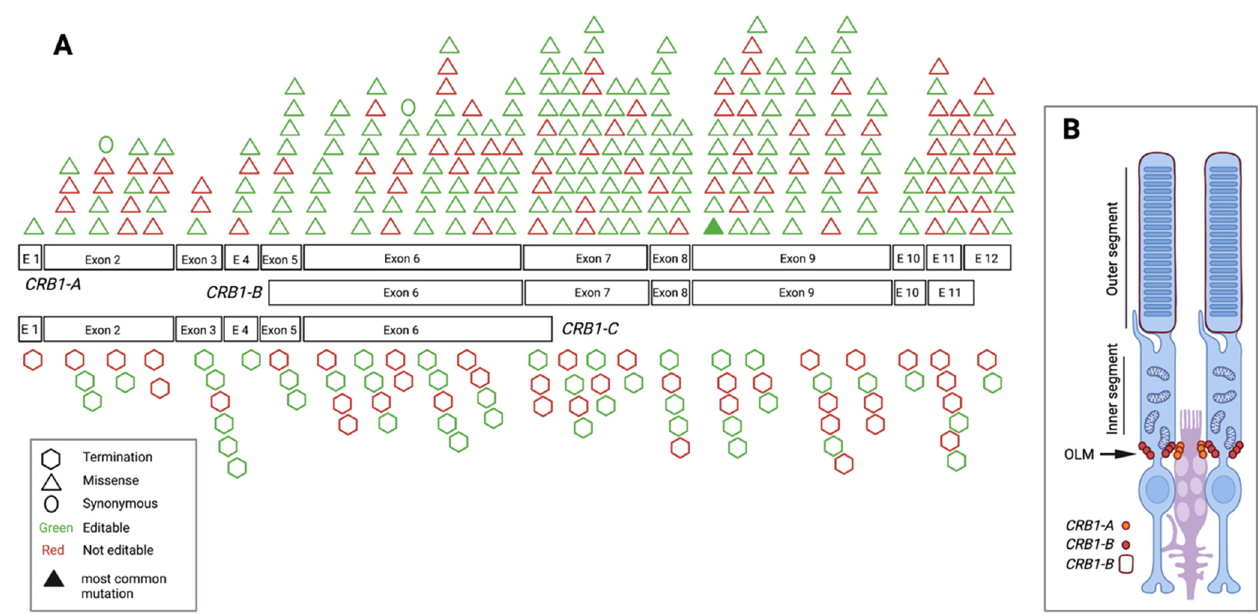
Figure 1. Schematic drawing of pathogenic, exonic single nucleotide variants (SNVs) along the CRB1 isoforms. ( A ) CRB1 has three retinal isoforms, from which CRB1-B is the most highly expressed overall. The most commonly reported pathogenic/likely pathogenic/conflicting pathogenic SNV across both datasets, c.2843G>A, p.Cys948Tyr, can be found in the first nucleotide of exon 9. ( B ) CRB1-B is found in photoreceptors (PR), whereas CRB1-A is found in Müller glia cells (MGCs).